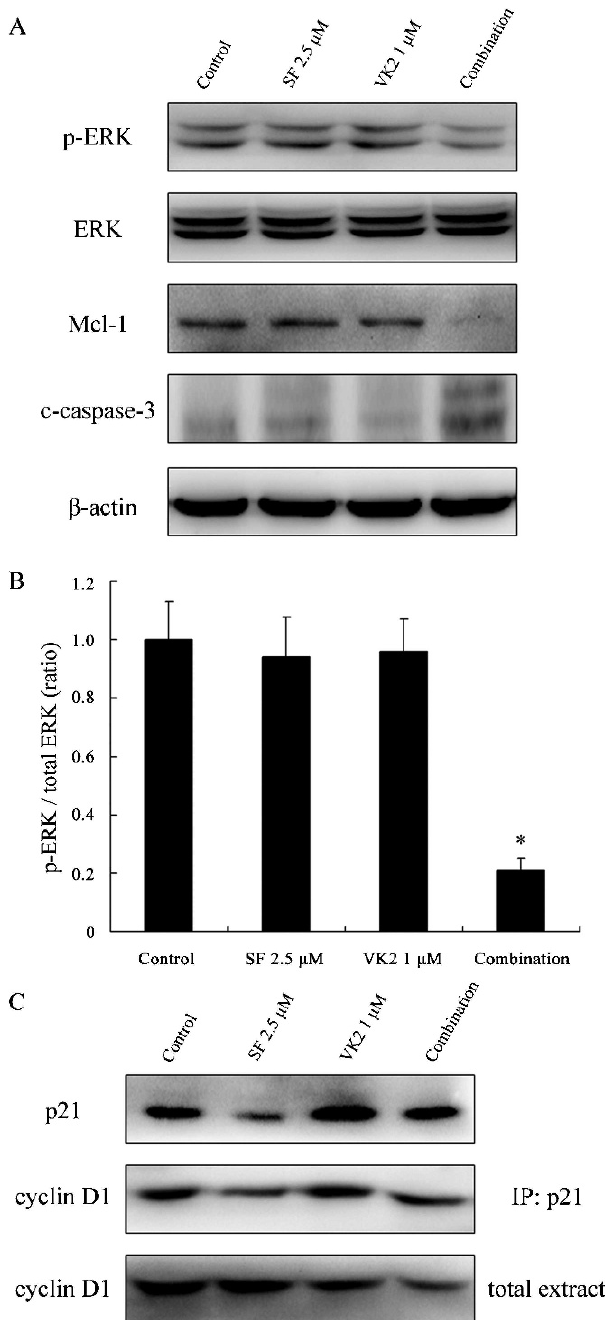
Figure 3 - Western blot analysis of HepG2 cells after combined treatment with sorafenib and VK2. (A) Sorafenib and VK2 synergistically inhibited the phosphorylation of ERK, and subse- quently led to Mcl-1 downregulation and caspase-3 cleavage. p- ERK: phosphorylated ERK. c-caspase-3: cleaved caspase-3. (B) The levels of p- ERK and ERK were quantitated by densitometry, and the ratios of these two proteins are displayed. Values represent the mean ¡ SD (n=3). * p , 0.05 vs. control or single-agent treatment. (C) Changes in p21 expression and the levels of cyclin D1 binding to p21. Representative results from three indepen- dent experiments with similar results are